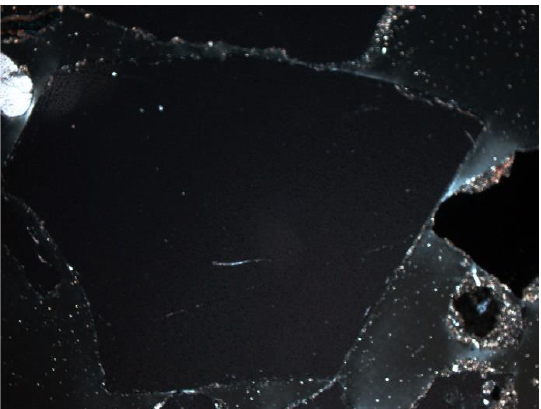
Figure 15. Glass in SP2 slag and ash sample, thin section, 1P, 200×,transmitted light.